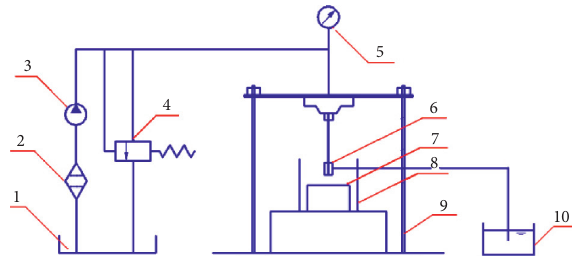
Figure 3: Experimental procedure of the pulsed abrasive water jet. (1) Water tank; (2) filter; (3) plunger pump; (4) safety valve; (5) pressure gage; (6) experimental tool; (7) rock; (8) iron box; (9) test bench; (10) water box (pure water or abrasive-containing